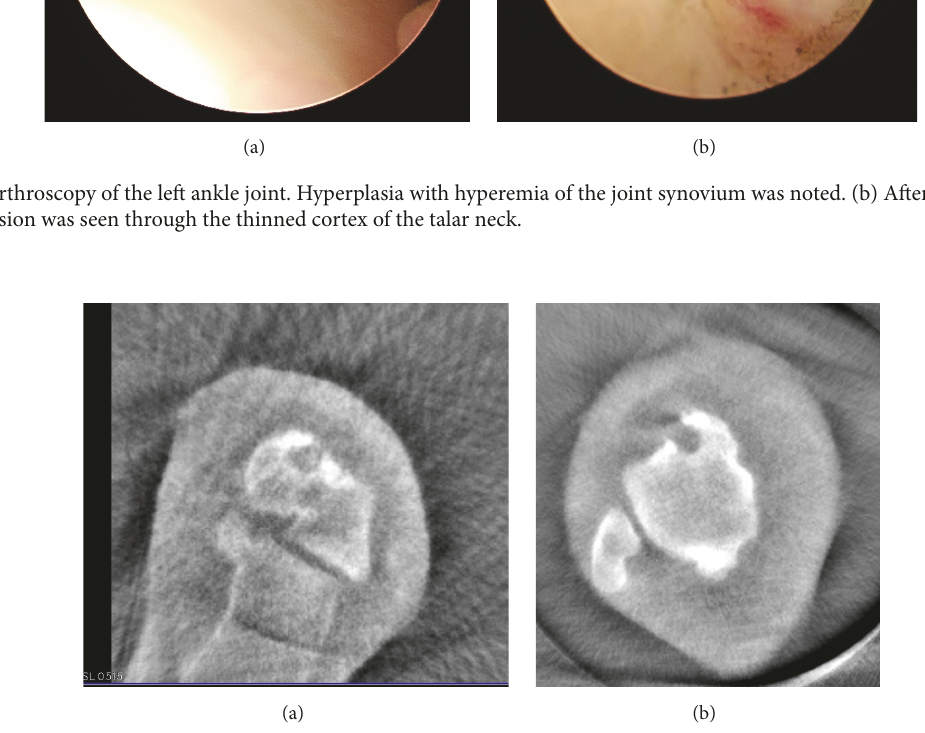
Figure 5: Intraoperative 3D C-arm-based axial reconstructed imaging before (a) and after (b) tumor resection. (a) Precise detection of the nidus was achieved before destruction of the cortex. (b) Complete tumor resection and appropriate bone preservation were confirmed